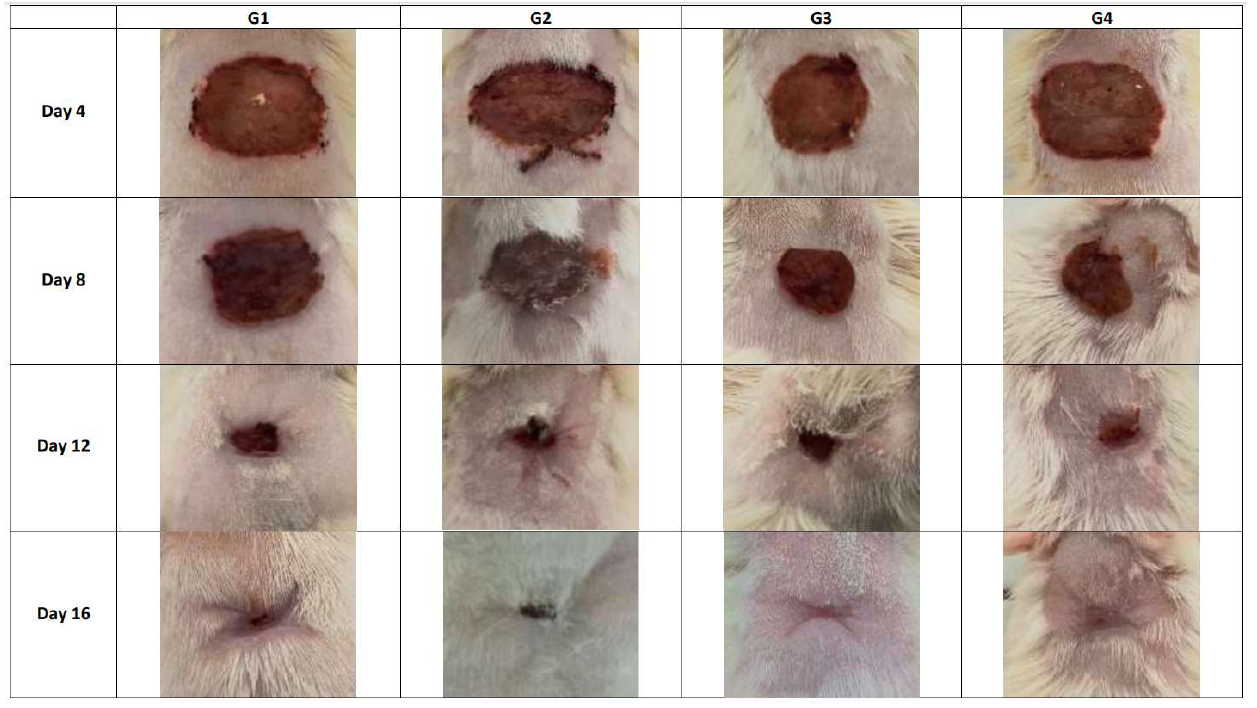
Figure 2 . Morphological representation of wound contraction from control and test groups at days 4 and 16 after the excision.